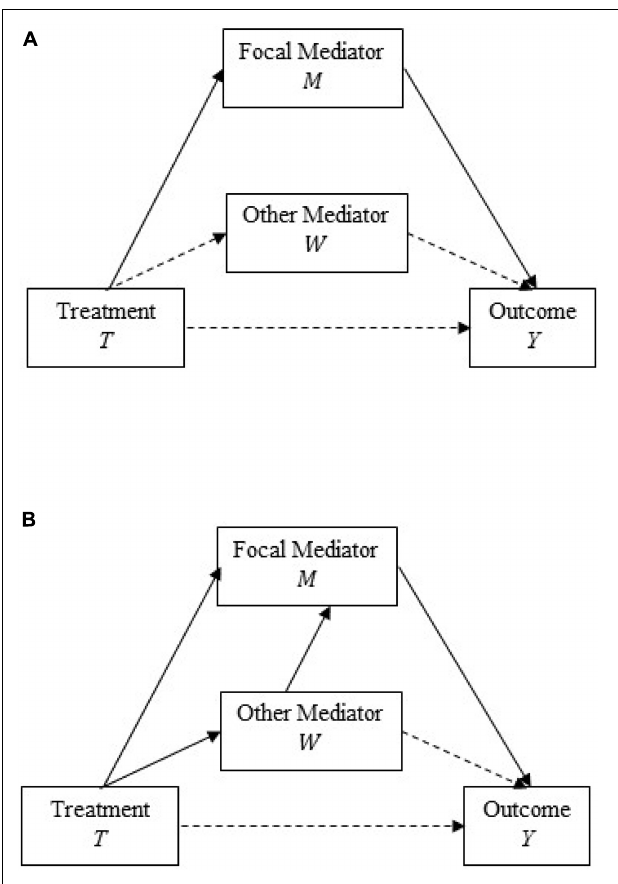
FIGURE 2 | Path diagram for mediation analysis model with multiple mediators. (A) Model with independent mediators. (B) Model with related mediators. In each panel, the solid arrows represent the average causal mediation effect (ACME) through the focal mediator. The solid and dashed arrows, together, represent the total effect of participation in the comprehensive college transition program. In panel (A) , the focal mediator is assumed to be independent of the other mediators. With this assumption, ACME estimates for each focal mediator are not allowed to be confounded by post-treatment changes in other mediators. In panel (B) , the focal mediator is allowed to depend on other mediators. Figure adapted from Imai and Yamamoto (2013). Copyright 2013 by K. Imai and T.